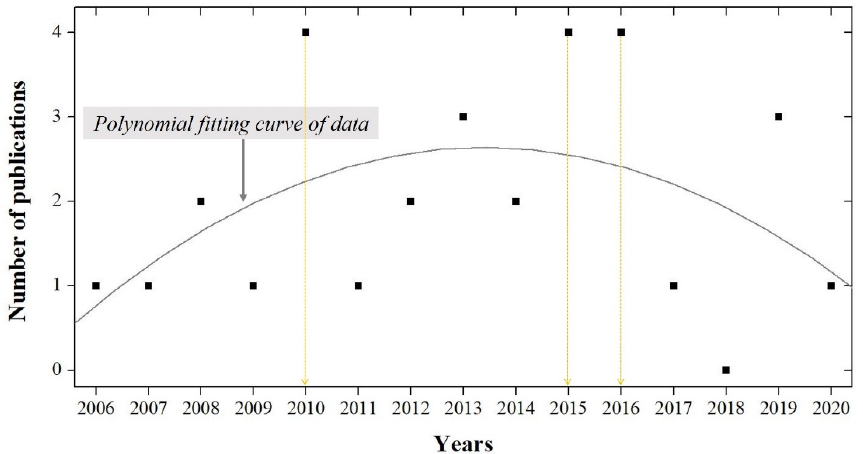
Figure 3. Graph of the number of publications per year, including the polynomial fitting curve.